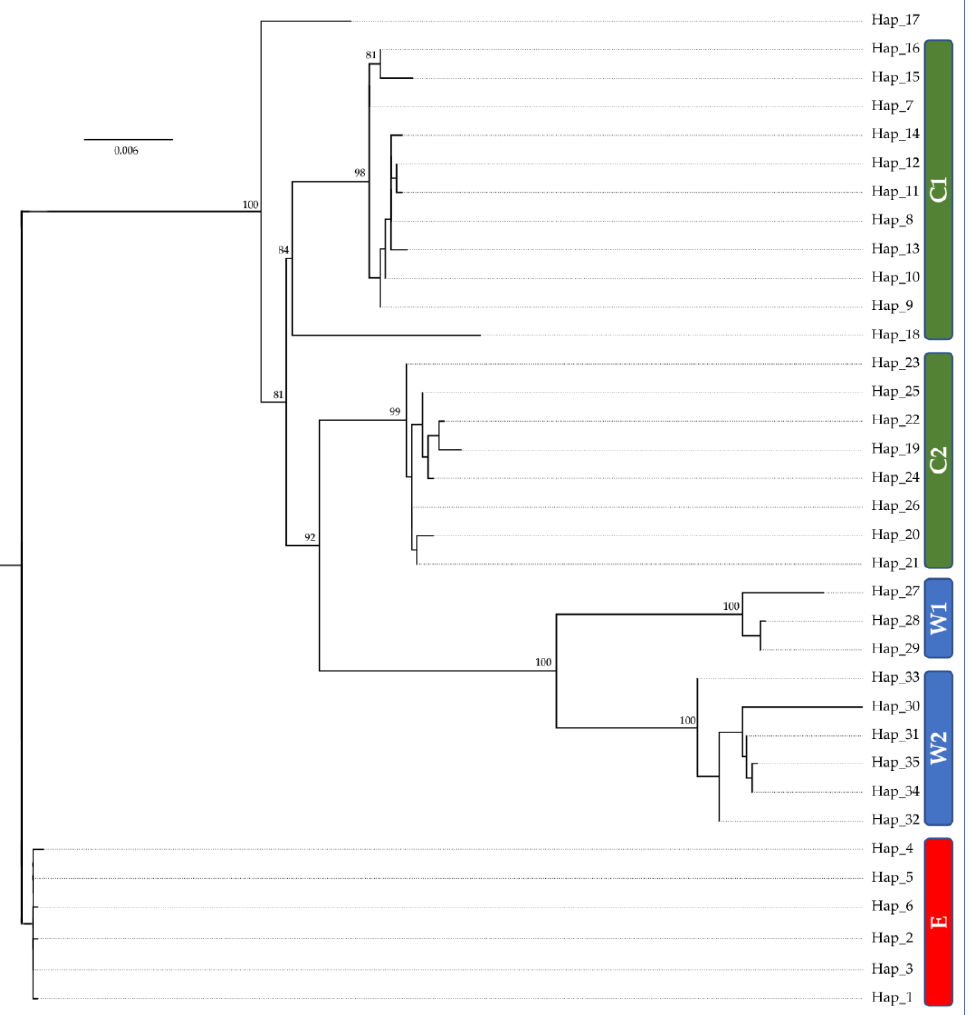
Figure 4. ML tree depicting phylogenetic relationship among 35 haplotypes defined by CYTB + COI + CR (2904 bp) sequences of the Nepal Himalayan langurs.